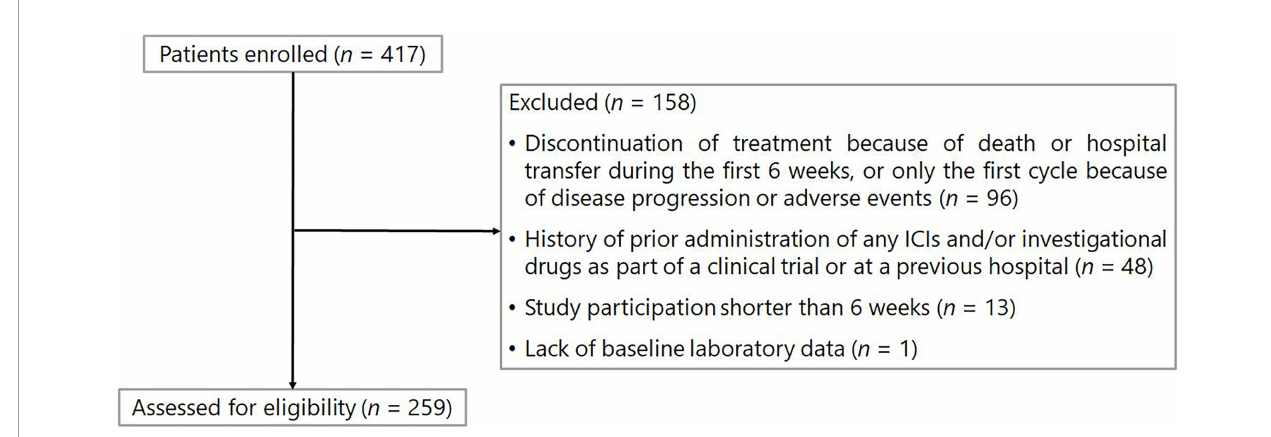
FIGURE 1 | Patient enrollment fl owchart. ICIs, immune checkpoint inhibitors.